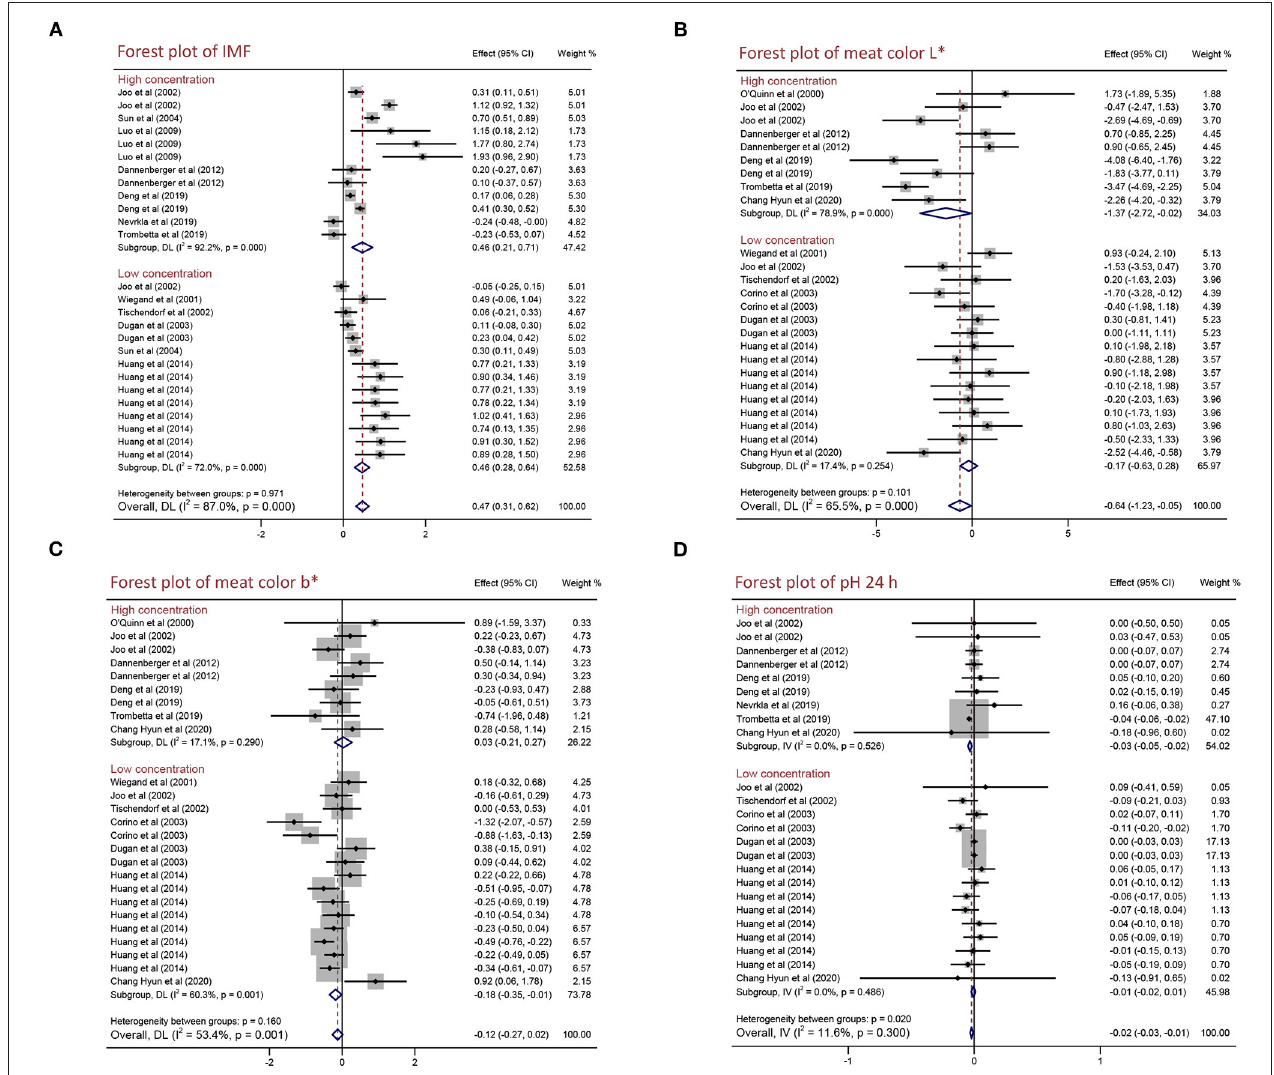
FIGURE 3 | Forest plot of the differences in the meat quality of pigs fed high/low PUFA supplementation concentration. (A) IMF, (B) meat color L*, (C) meat color b*, and (D) pH 24h. WMD, weighted mean difference; CLA, conjugated linoleic acid. The small solid diamond represents the point estimate for each individual trial, and the horizontal line extending from each solid diamond represents the upper and lower limits of the 95% CI. The size of the shaded square indicates the relative weight of the trial in the meta-analysis. The hollow diamond represents the WMD and 95% CI of the trials, no intersection of the diamond and the solid black line in the middle indicates a significant difference ( p < 0.05), vice